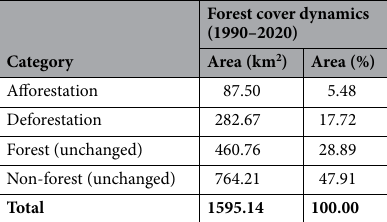
Table 5. Net change in forest cover (1990 to 2020).